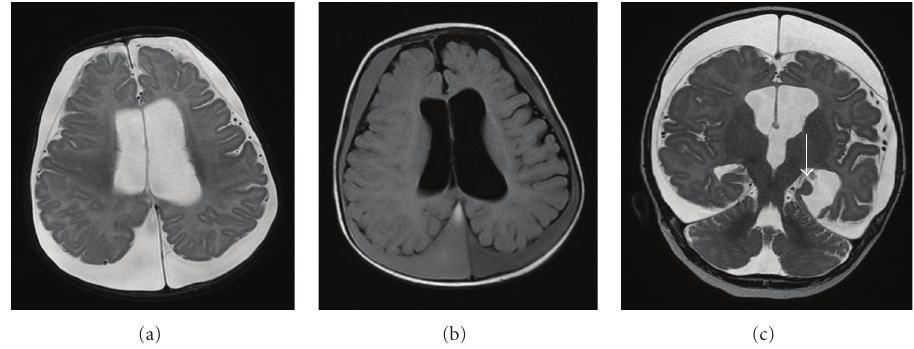
Figure 2: A 4-month-old infant was presented with a large head circumference followed by seizure-like episodes. Axial T2-weighted image (a) showed hydrocephalus and prominent CSF space along bilateral cerebral convexities. The fluid was subdural hematomas because the signal intensity of the fluid is di ff erent from that of CSF on FLAIR T2-weighted image (b). Coronal T2-weighted image showed hypoplasia of the left